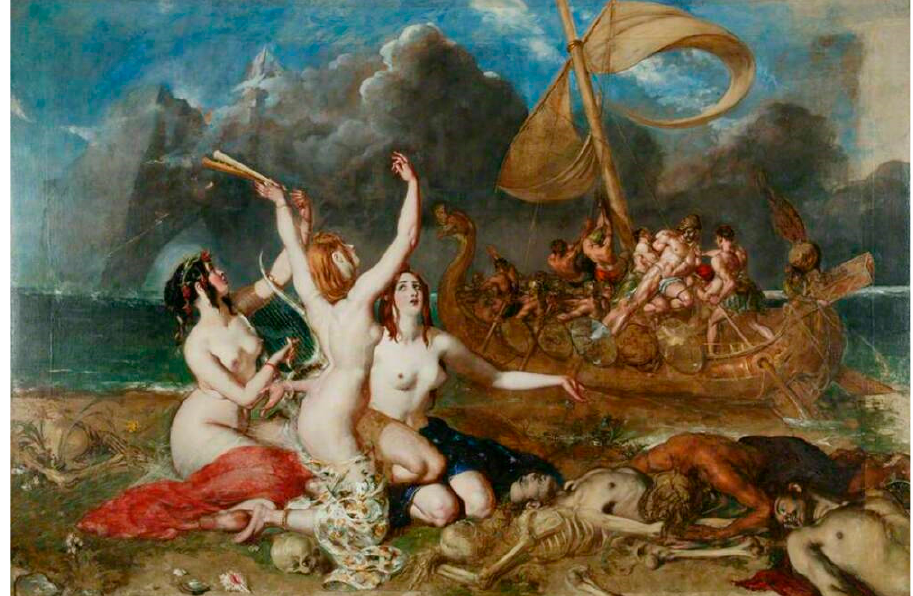
Figure 4. The Sirens and Ulysses by William Etty, circa 1837. Oil on canvas, 297 × 442.5 cm. “Manchester Art Gallery”. This image is in the public